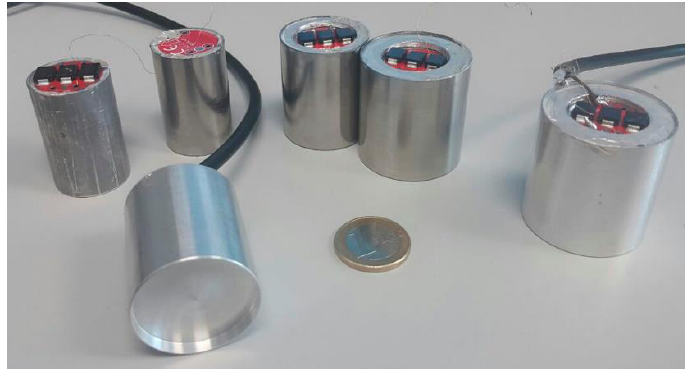
Figure 7. Three aluminum and three stainless steel sensors with 0.3 mm front-plate thickness and radius: 11.5, 15, and 17.5 mm. Each device is supported by a cylindrical structure 1.0 mm thick and 40.0 mm long. The ceramic material used in each device is PI Ceramics 255 with a 10.0 mm radius and 0.3 mm thick.